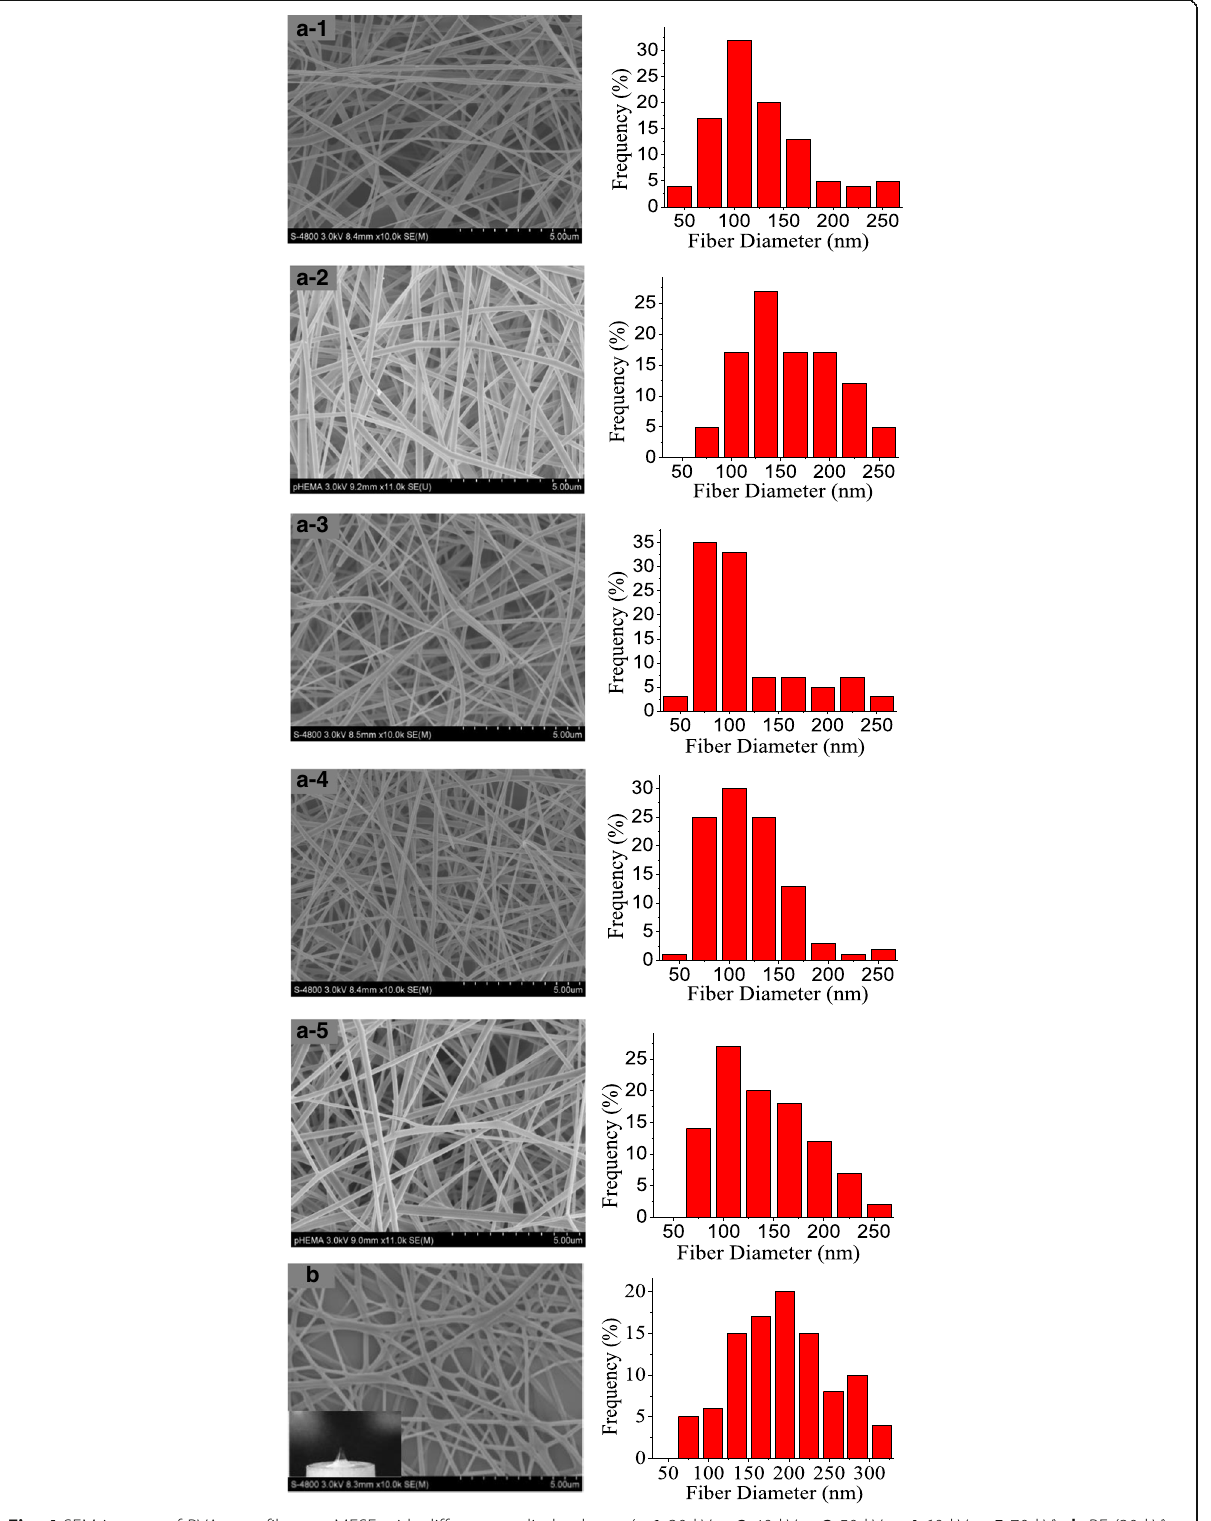
Fig. 4 SEM images of PVA nanofibers. a MFSE with different applied voltage, ( a-1 30 kV, a-2 40 kV, a-3 50 kV, a-4 60 kV, a-5 70 kV);. b BE (30 kV). Inset : a photograph of BE process. The right figures were the according diameter